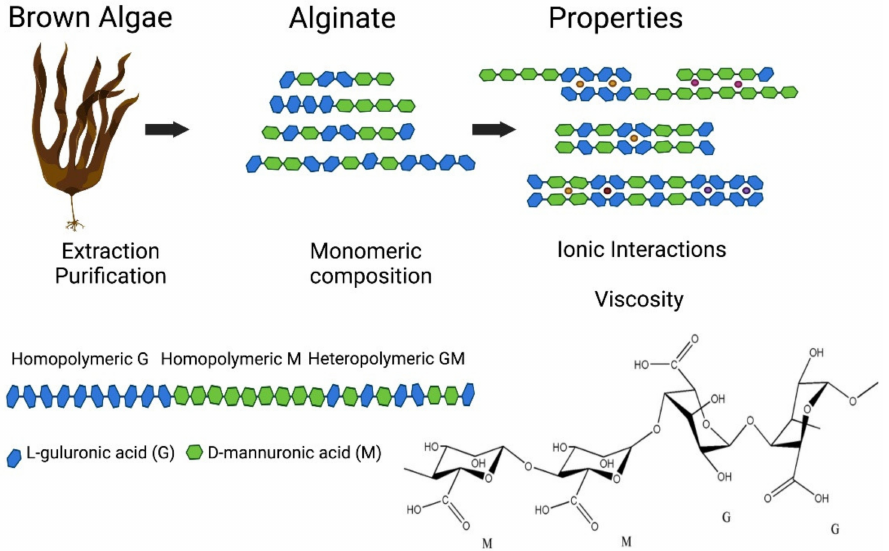
Figure 7. Alginate is extracted and purified from a wide variety of brown algae. It is composed of α -L-guluronic acid (G) and β -D-mannuronic acid (M) blocks, the precise combination of which impact the properties of the alginate material and its potential biomedical utility. Image is based on